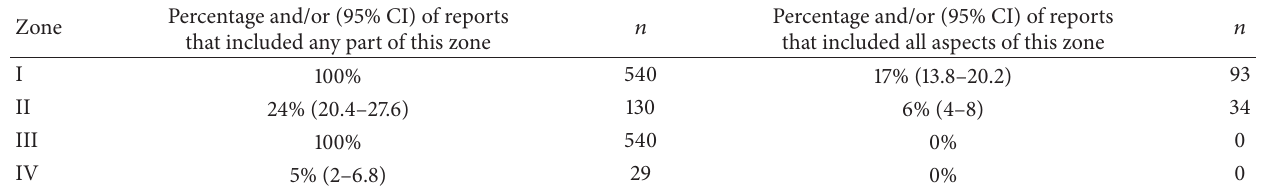
Table 2: Percentages of the surgical reports that described findings in any structure or all structures of every pelvic zone.